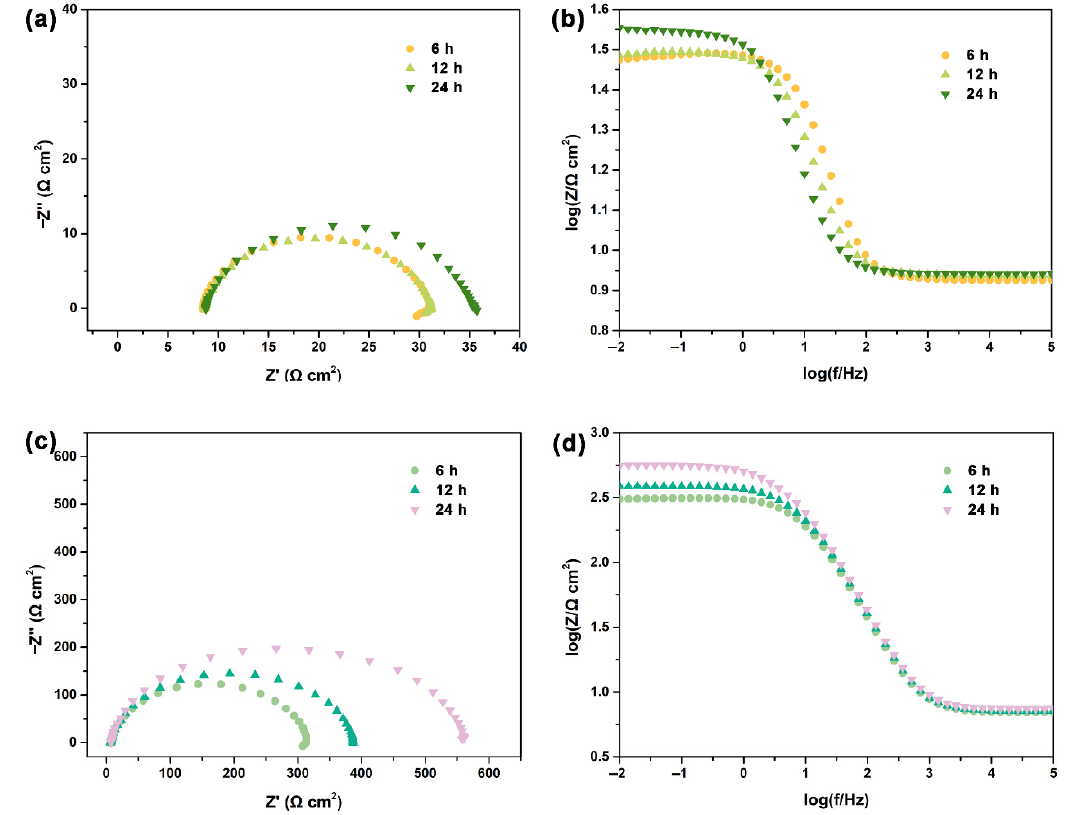
Figure 7. The EIS results of Q235 carbon steel after various durations of exposure to 1 M HCl solution in the ( a , b ) absence and ( c , d ) presence of 400 ppm NCDs.